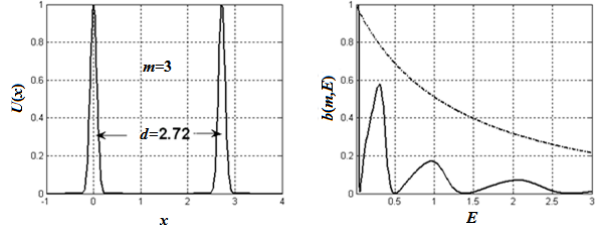
Figure 4: Composite barrier (left) and reflection coeflcient (right, dotted line - reflection coeflcient of single barrier)